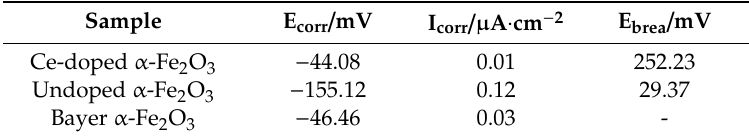
Figure 9. Electrochemical test of samples. ( a ) Ce-doped α -Fe 2 O 3 sample; ( b ) Bayer α -Fe 2 O 3 sample; ( c ) undoped α -Fe 2 O 3 sample. Table 2. Electrochemical parameters of the Tafel curves of the three nanoparticles in 3.5% NaCl solution b